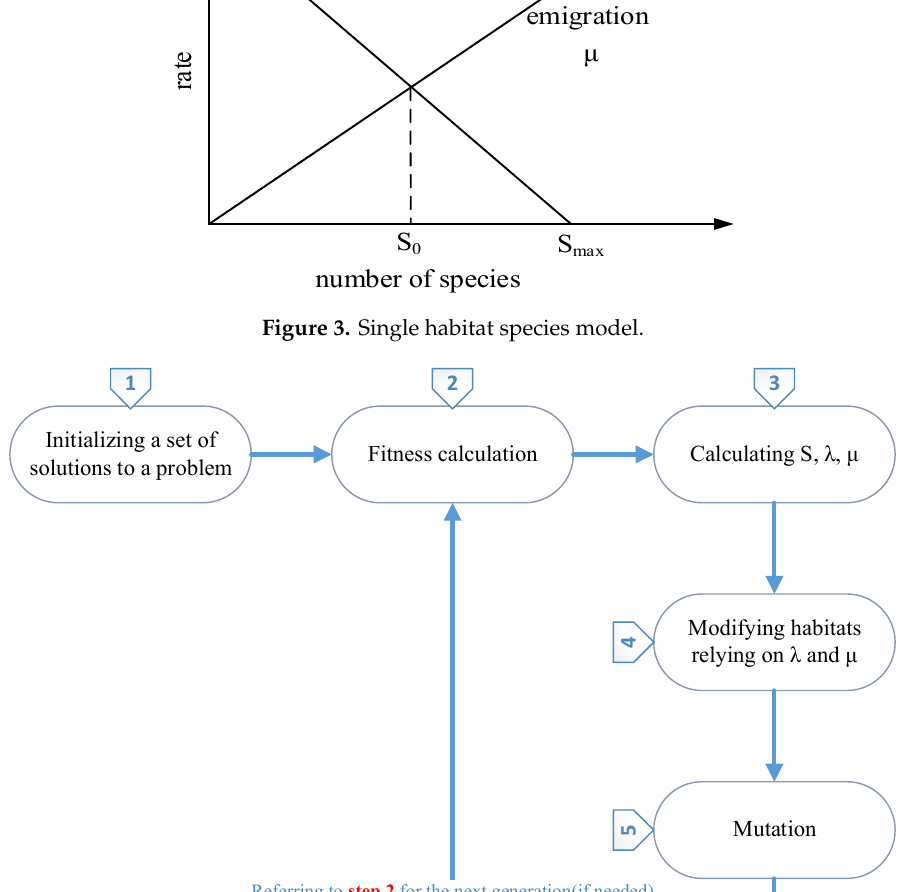
Figure 4. The main steps for implementing biogeography-based optimization algorithm (BBO) [39].